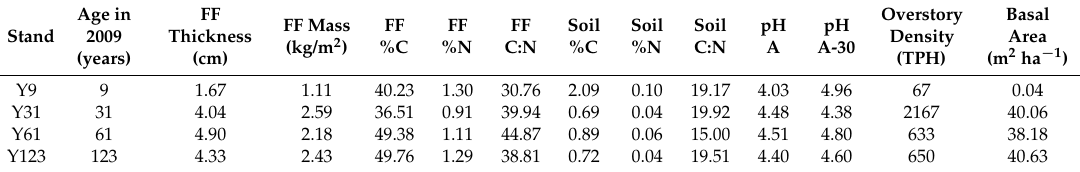
Table 1. Forest floor, soil (0–30 cm), and overstory structure characteristics of 9, 31, 61, and